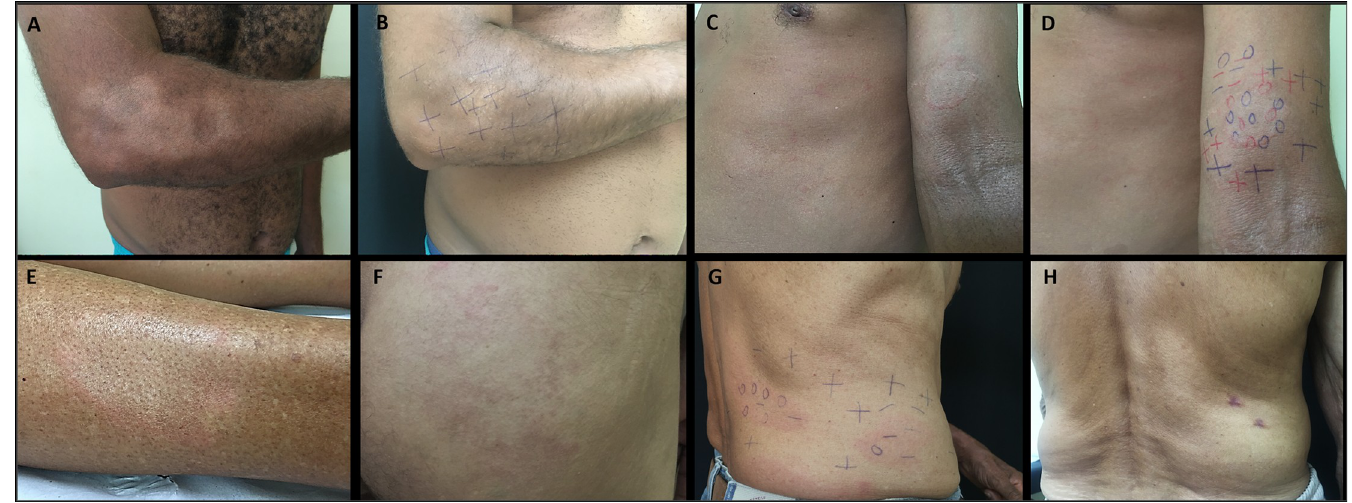
Fig 4. Images of different locations (elbow, arm, leg, buttock, anterior and posterior trunk) of leprosy lesions. (a) Hypochromatic anesthetic macule with irregular edges on the right elbow and forearm; (b) the same previous patient, after 12 months of multi drug therapy, with improvement of skin sensitivity; (c-d) typical borderline lesions on the left arm and trunk; (e) hypochromatic macule with infiltrated erythematous border on the right leg; (f) typical borderline lesions on the buttocks; (g) hypochromatic macules and erythematous plaques on the back; (h) the same previous patient, after 3 months of multi drug therapy with new hypochromatic macules on the back. Legend: 0 (anesthetic point);—(hypoesthetic point); + (normoesthesic point).